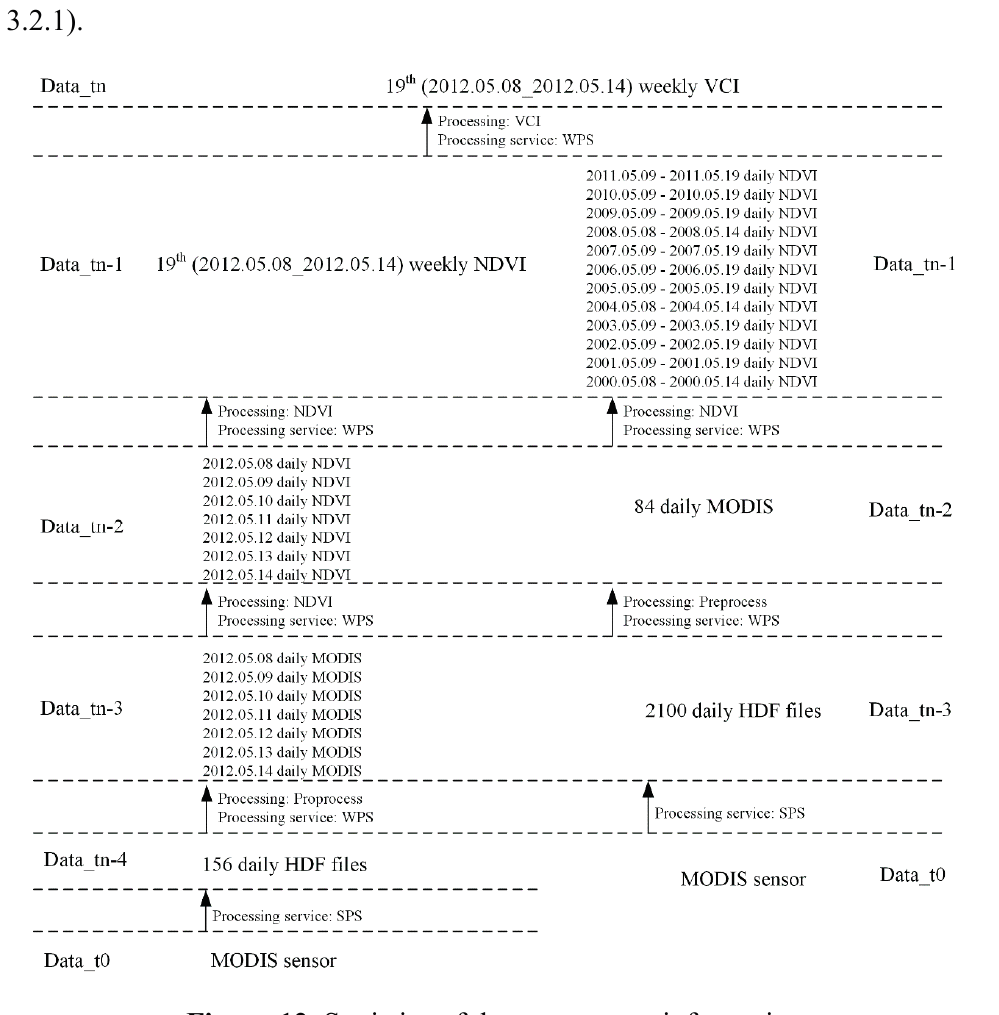
Figure 12. Statistics of the provenance